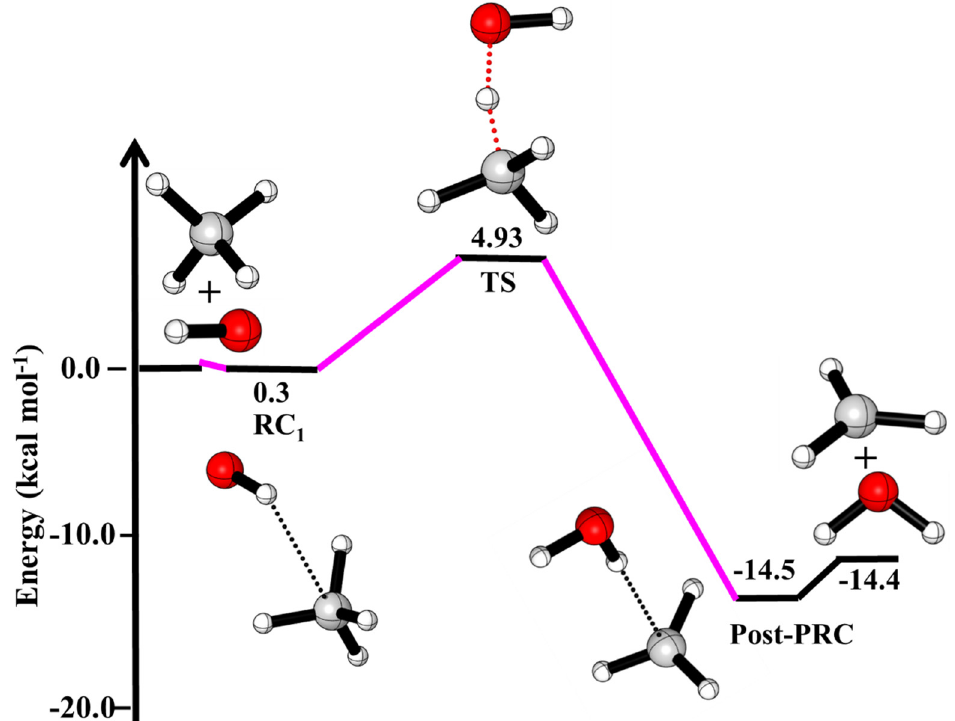
Figure 1. Potential energy surface for the · OH + CH 4 reaction leading to form methyl radical and water. The stationary point was computed at the CC//M06-2X level and ZPE correction obtained from vibrational analysis using M06-2X.